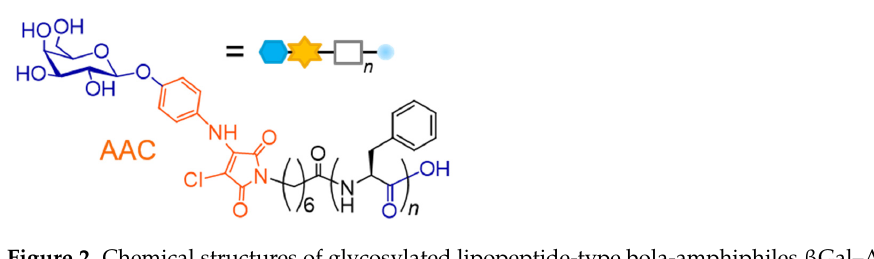
Figure 2. Chemical structures of glycosylated lipopeptide-type bola-amphiphiles β Gal–AAC–C6–F n ( n = 1–4).